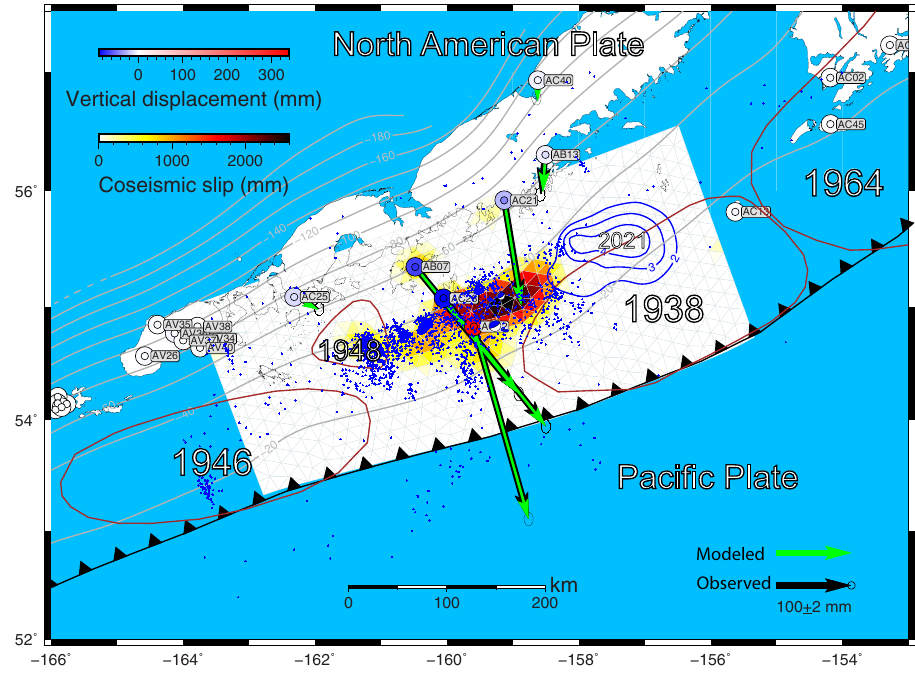
Fig. 2 Comparison of observed and predicted 3-D coseismic displacements associated with the 2020 Mw 7.8 Simeonof Island, Alaska earthquake. The error ellipses represent 95% con fi dence. The large and small colored circles represent the observed and predicted vertical displacements, respectively. Solid gray lines depict the depth contours of plate interface from the Slab2 model 65 . Small blue dots are aftershocks from the U.S. Geological Survey (USGS) catalog during the 87 days up to the Mw 7.6 Sand Point aftershock. Brown curves denote the rupture areas of the 1938, 1946, 1948, and 1964 earthquakes. The 2021 Mw 8.2 Chignik earthquake coseismic slip pattern from USGS is outlined in blue contours with slip ≥ 2 m.